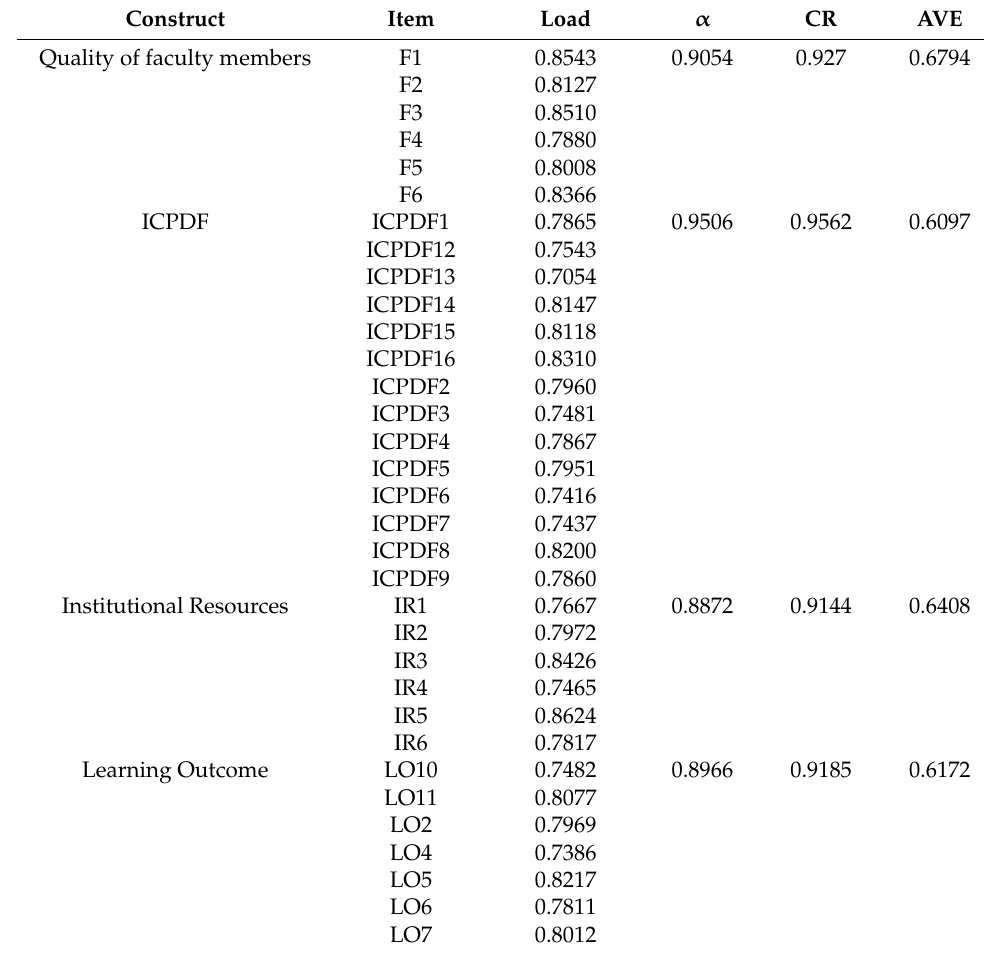
Table 2. Load, alpha, CR, and